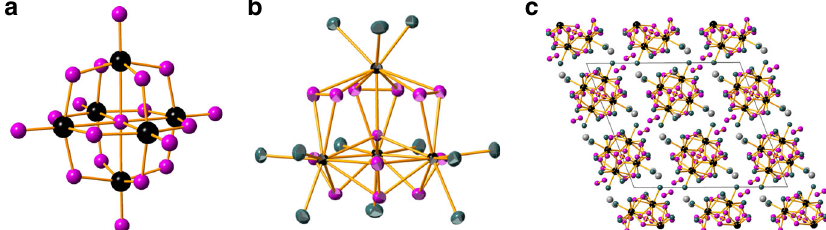
Fig. 1 Transition metal and actinide clusters. Ball and stick representations of a the hexanuclear isopolyanion M 6 O 19 8 − . b Thermal ellipsoid plot of the anionic cluster [Pa 4 O(O 2 ) 6 F 12 ] 2 – (ellipsoids at 50% probability). c Packing diagram for Rb 6 [Pa 4 O(O 2 ) 6 F 12 ] ∙ (H 2 O 2 ) 4 . The metal sites (Nb or Pa) are in black, oxygen atoms in magenta, fl uorine in turquoise, and rubidium in